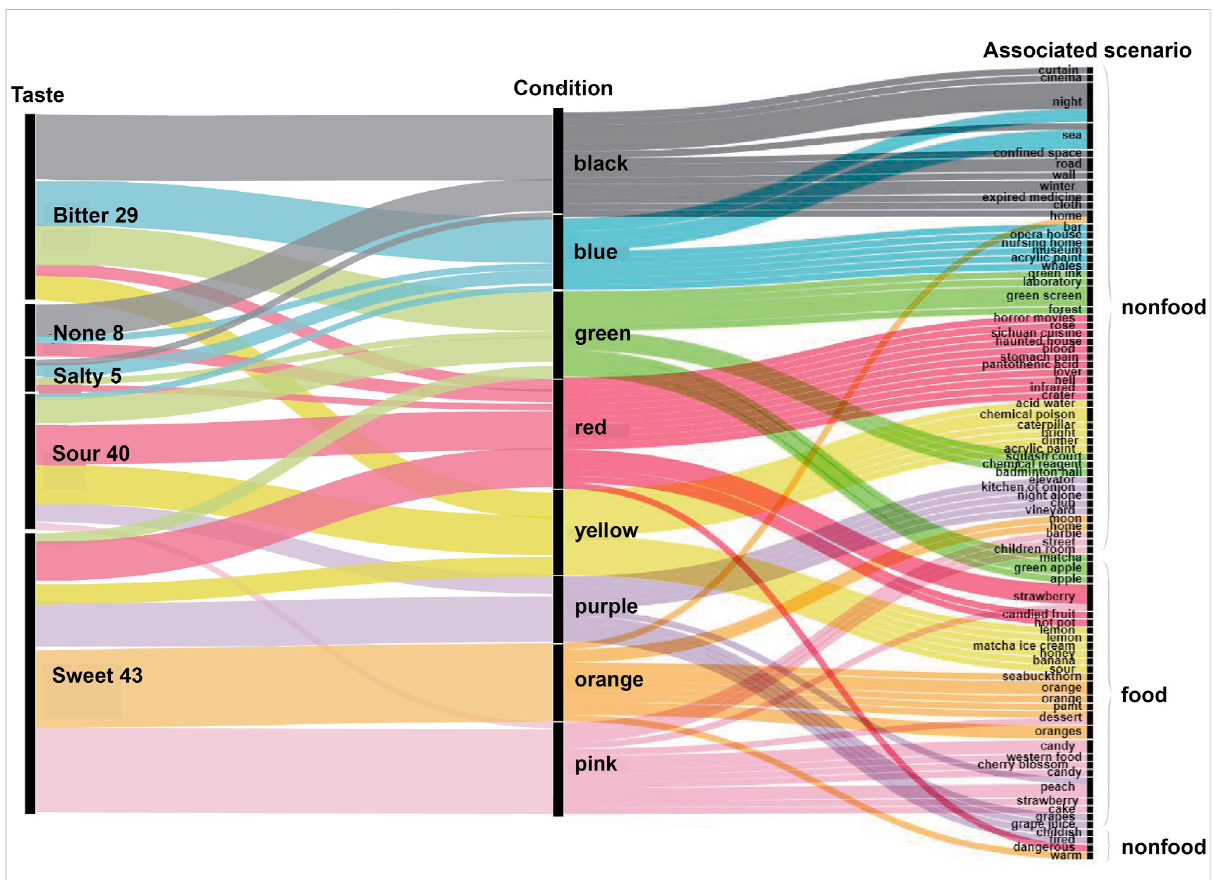
FIGURE 9 Generalassociatedobjectsandscenesunderdifferenttastechoice( Q2-3 ).Participantsgavetheanswersaftermatchingtheambientcolorwith thetaste.Answersofassociatedscenariowerecategorizedintofoodandnon-foodandlistedintherightside.Lineswerecoloredforindicatingwhat ambient colors the answers were based on. Notice that, not all the conditions have associated